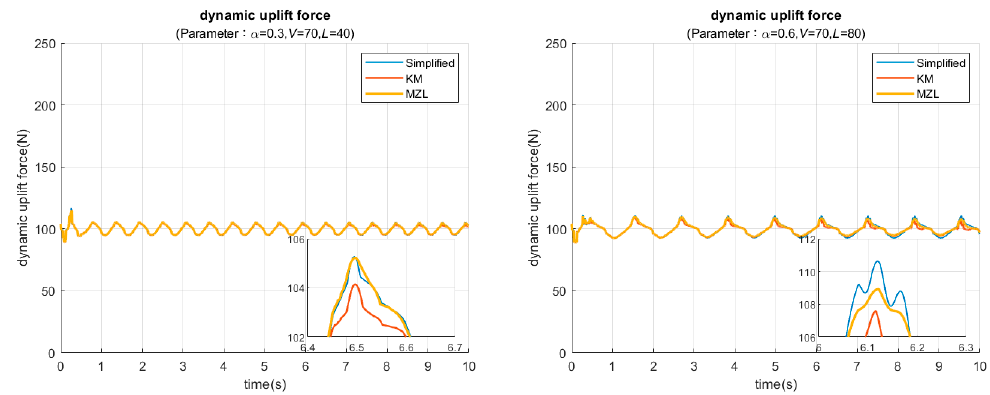
Figure 12. The dynamic uplift force. Table 4. The comparative results of the vibration suppression efficiency and the computational cost for α = 0.3, 0.5.